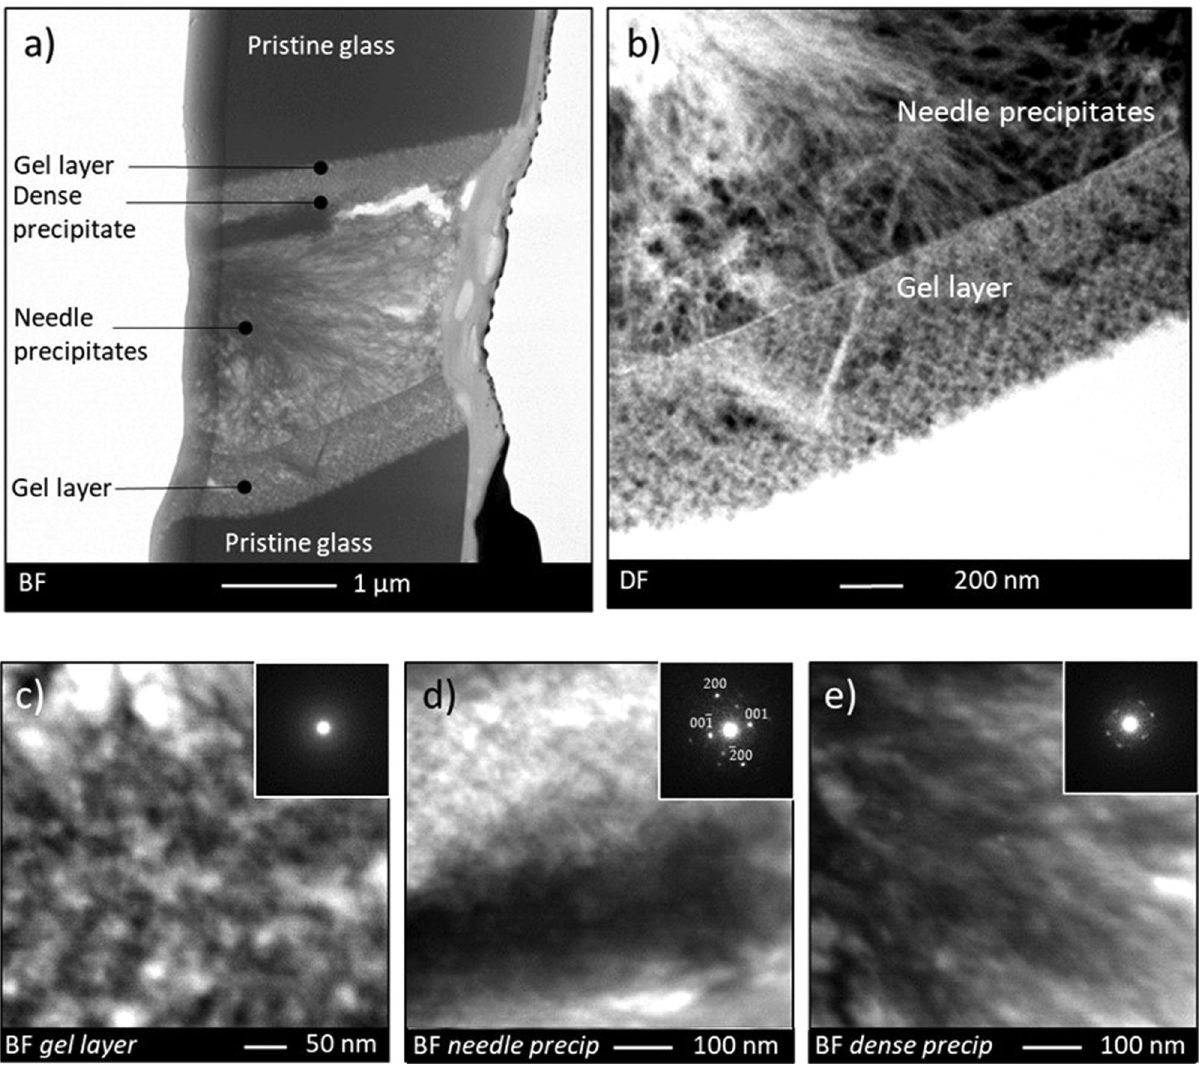
Fig. 5 Scanning transmission electron microscopy analysis of CaZn28 glass after 84 d of dissolution in Evolved Cement Water. a Bright fi eld image showing the interface between two adjacent grains that had been cemented together by secondary phases, highlighting several regions of different morphology or chemistry; ( b ) dark fi eld micrograph of the gel layer and Ca-silicate rich precipitates; and high resolution bright fi eld images and associated selective area electron diffraction patterns of: ( c ) the gel layer; ( d ) the needle precipitates; and ( e ) the dense